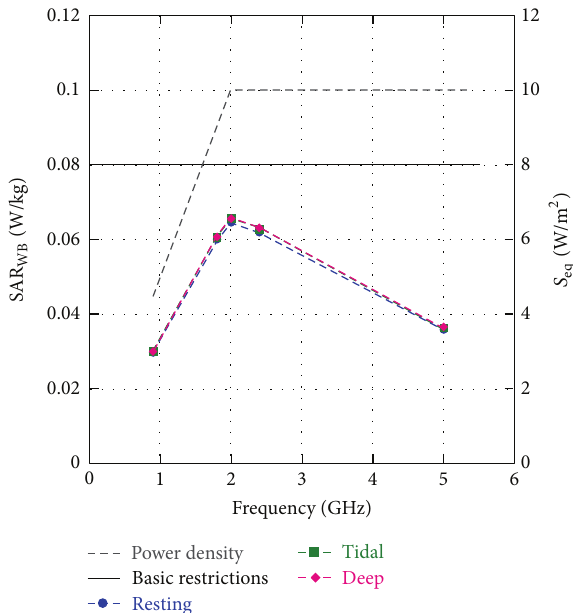
Figure 3: Whole body SAR for the RS, TB, and DB models and the input power density reference level allowed for general public in ICNIRP and IEEE 2005